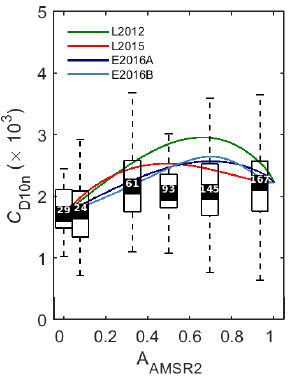
Figure 7. As Fig. 6a but for the ice fraction derived from the AMSR2